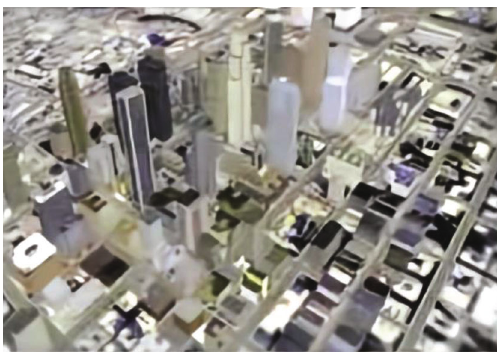
Figure 5: Virtual Los Angeles